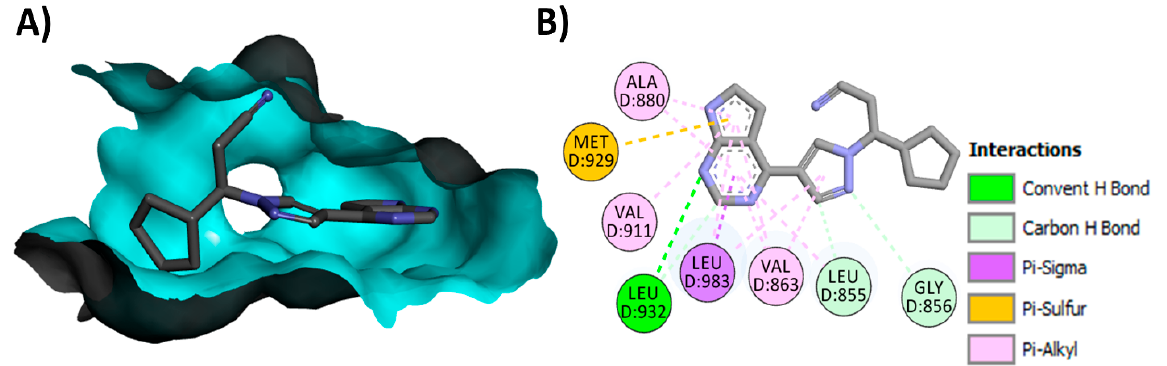
Figure 52. Binding modes of ruxolitinib (shown as sticks) into JAK2 JH1 (pdb: 6VGL): ( A ) 3D binding mode, receptor shown as a hydrogen bond surface; ( B ) 2D binding mode showing different types of interactions with JAK2 JH1; hydrogen atoms were omitted for clarity; this figure was generated using Discovery Studio Visualizer (V16.1.0.15350).